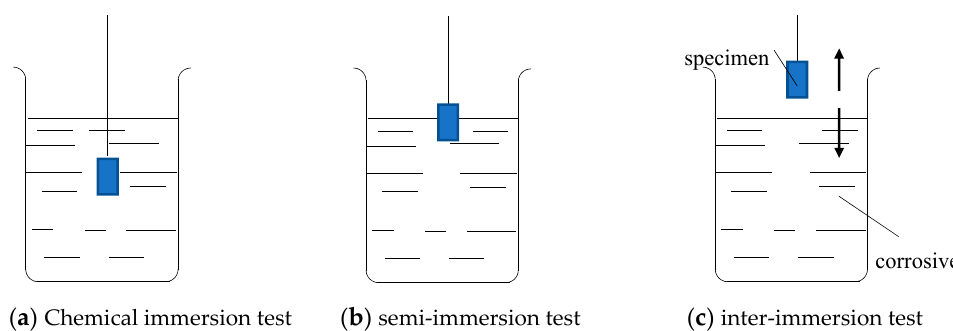
Figure 11. Corrosion tests in the laboratory.